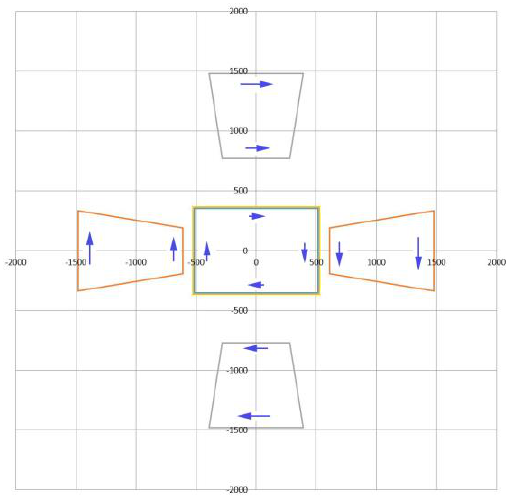
Figure 2b : Magnitude of Image Motion: Angular motion blur (Yaw) at different image positions